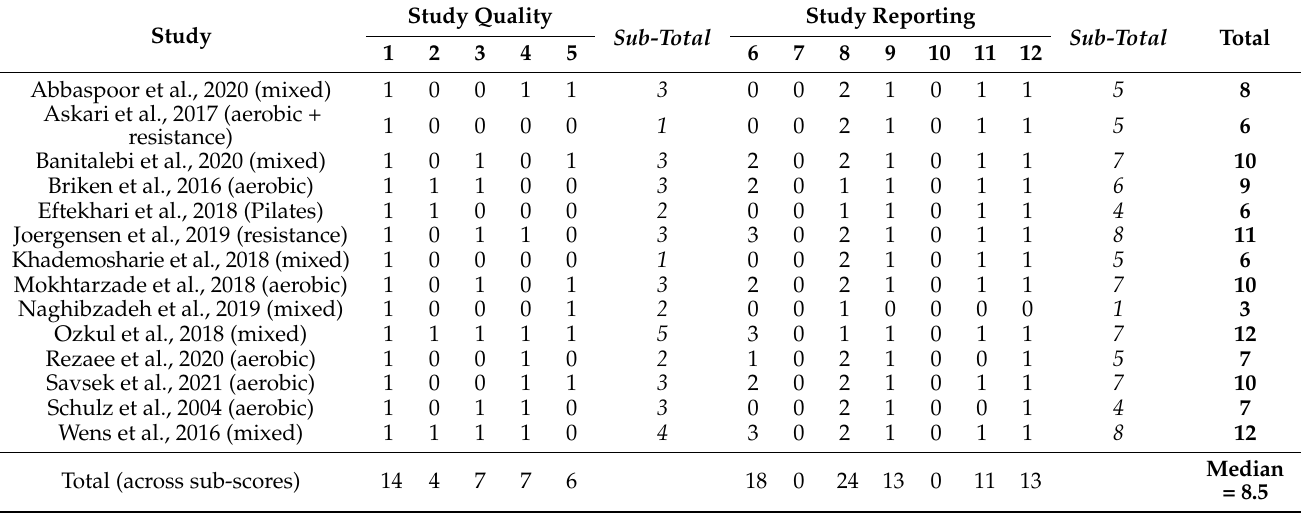
Table 1. TESTEX study quality